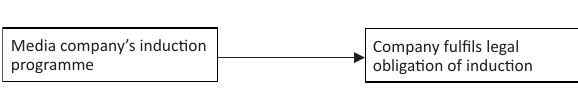
FIGURE 2: Media company’s programme theory.